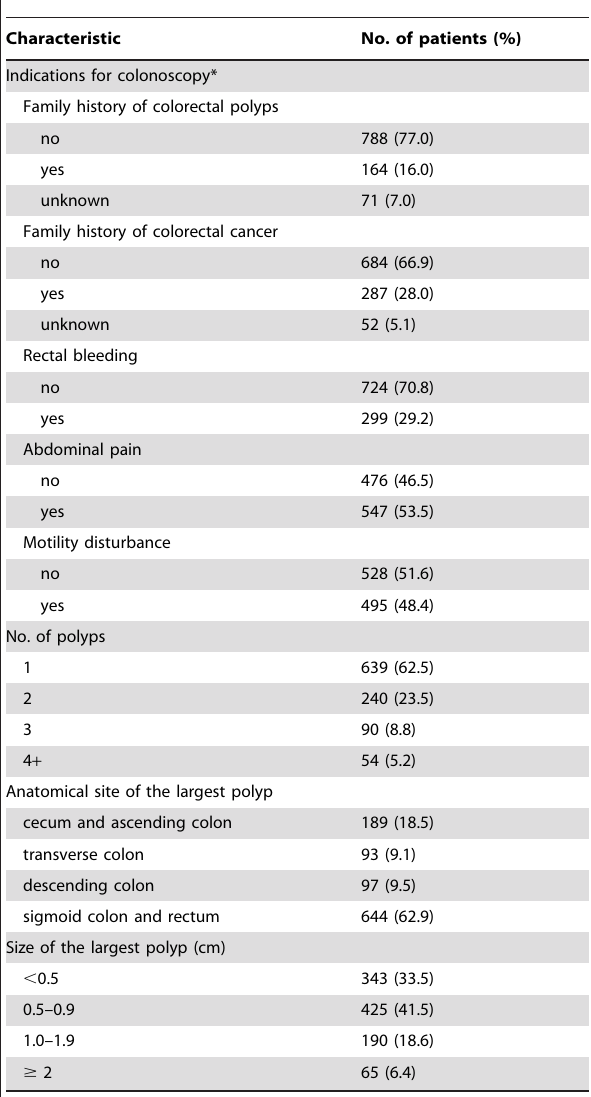
Table 1. Patient demographic and lifestyle characteristics at enrollment (n=1023).